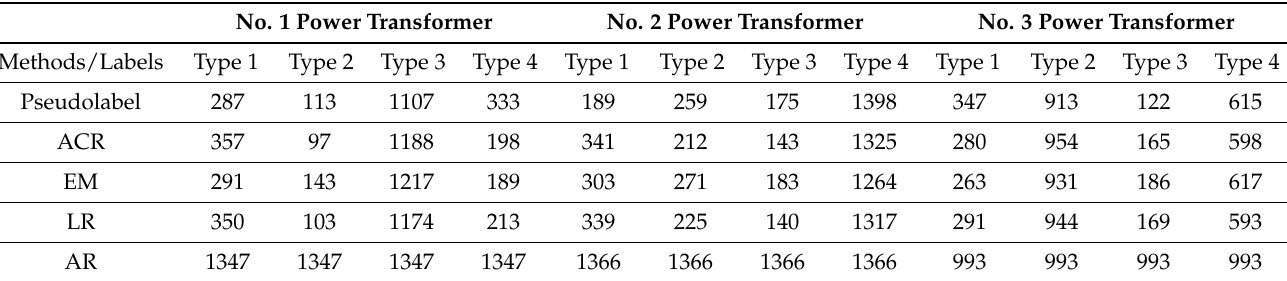
Table 4. Sample distribution of each power